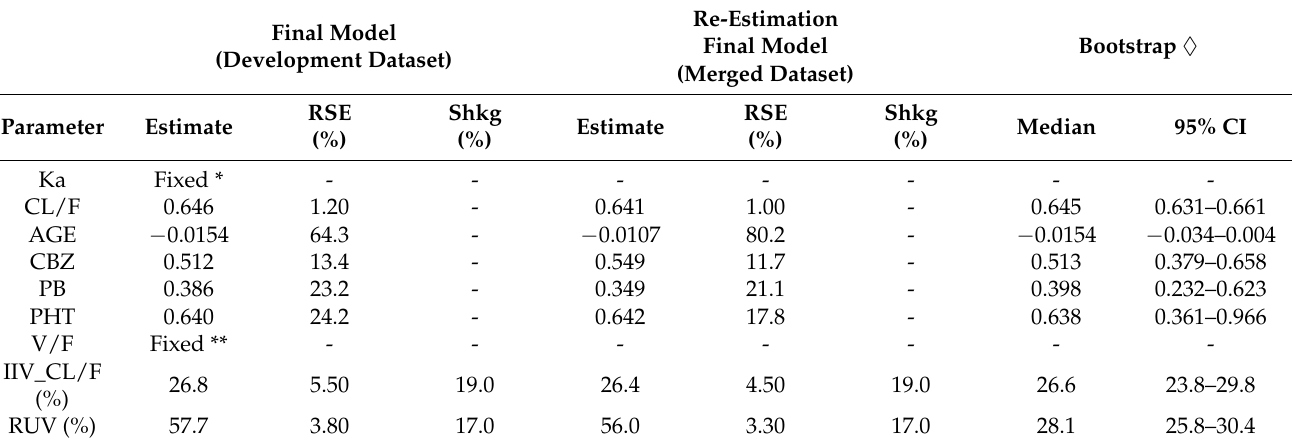
Table 2. PK parameters estimates (development, bootstrap and merged dataset